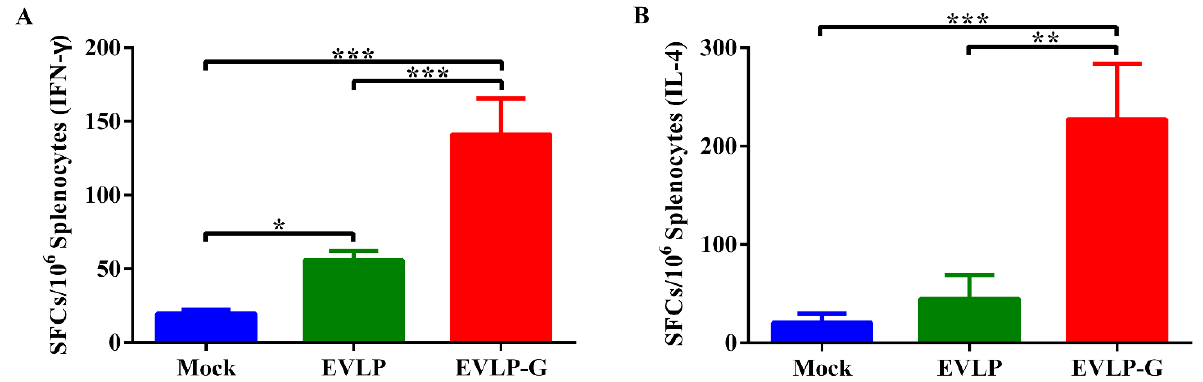
Figure 3. ELISpot analysis of IFN-γ and IL-4 secretion in mouse splenocytes. The splenocytes were collected from each group 2 weeks after the second immunization, and were treated